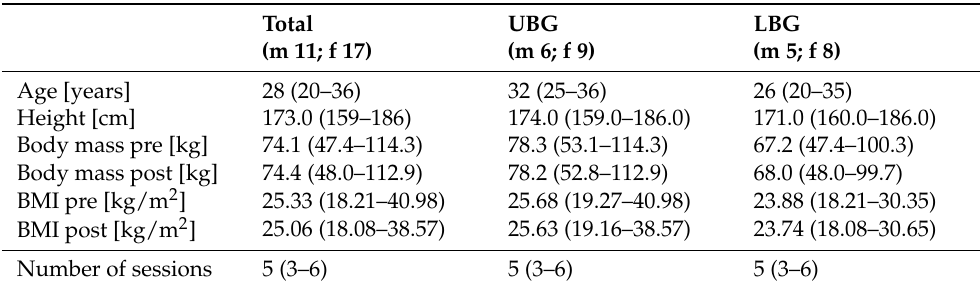
Table 1. Characteristics presented as medians (ranges) of the total collective ( n = 28) and the two